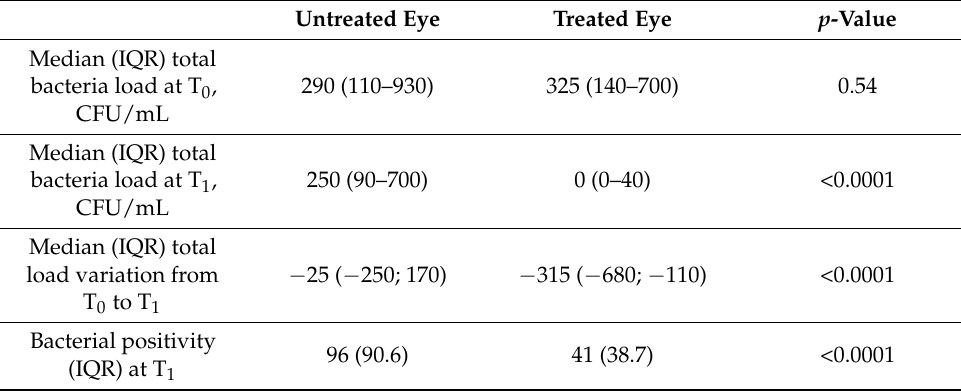
Table 2. Comparison of total bacteria load between T 0 and T 1 time-points. T 0 T 1 p -Value Median (IQR) total bacteria load, treated 325 (140–700) 0 (0–40) <0.0001 eye, CFU/mL Median (IQR) total bacteria load, 290 (110–930) 250 (90–700) 0.29 untreated eye, CFU/mL IQR = Interquartile range, CFU/mL = Colony Forming Units/mL. Table 3. Comparison of outcomes between the untreated and treated eye. Untreated Eye Treated Eye p -Value Median (IQR) total bacteria load at T 0